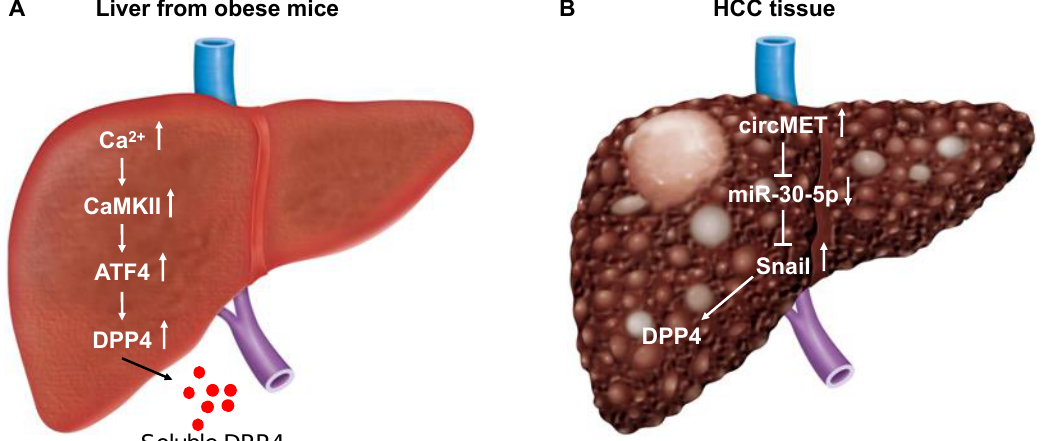
Figure 1. Schematic diagram depicting the induction of CD26/DPP4 expression in the liver of obese mice ( A ) and in HCC tissue ( B ). ( A ) In obese mice and humans, a pathway in hepatocytes involving Ca 2+ -calmodulin-dependent protein kinase II (CaMKII) regulates activating transcription factor 4 (ATF4). Activation of ATF4 leads to induction of dipeptidyl peptidase (DPP4) and secretion of soluble DPP4. ( B ) MET proto-oncogene receptor tyrosine kinase ( MET ) derived circular RNA (circRNA) (circMET) is the most overexpressed in HCC tissues compared to non-tumor liver tissues among the circRNAs derived from the chromosome 7q21 – 7q31 region. CircMET acts as a sponge for microRNA (miR)-30-5p, which downregulates Snail. Snail upregulates DPP4 expression by interacting with the enhancer element (region between 140,810 and 96,828 base pairs upstream of the DPP4 translation start site) of DPP4.